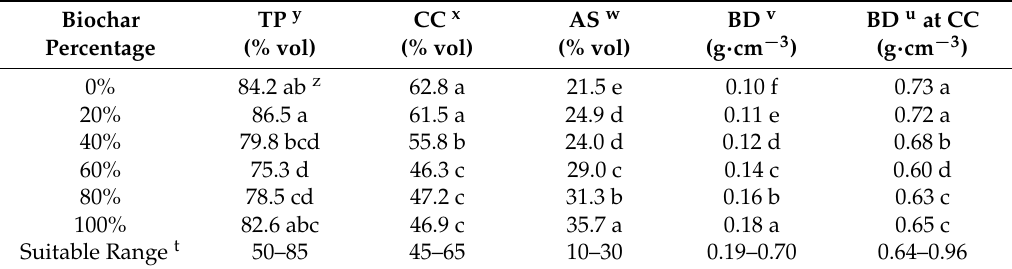
Table 1. Root substrate physical properties (total porosity, TP; container capacity, CC; air space, AS; and bulk density, BD) of Sunshine Mix #1 amended with six different percentages of biochar (by volume).